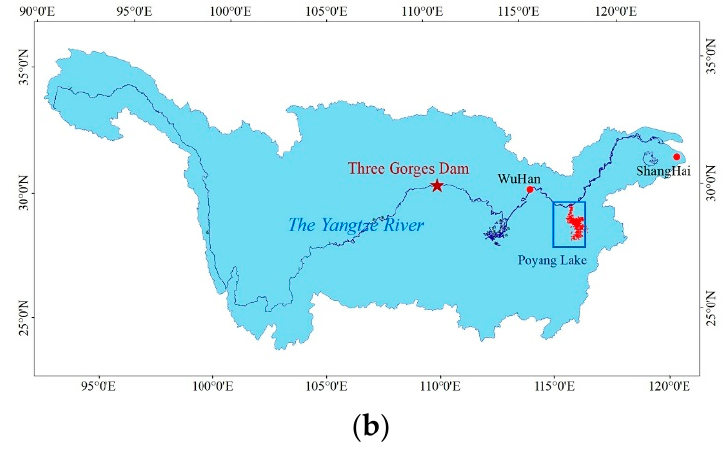
Figure 1. ( a ) Study area distribution in the Poyang Lake basin. ( b ) Location of Poyang Lake in the Yangtze River Basin.